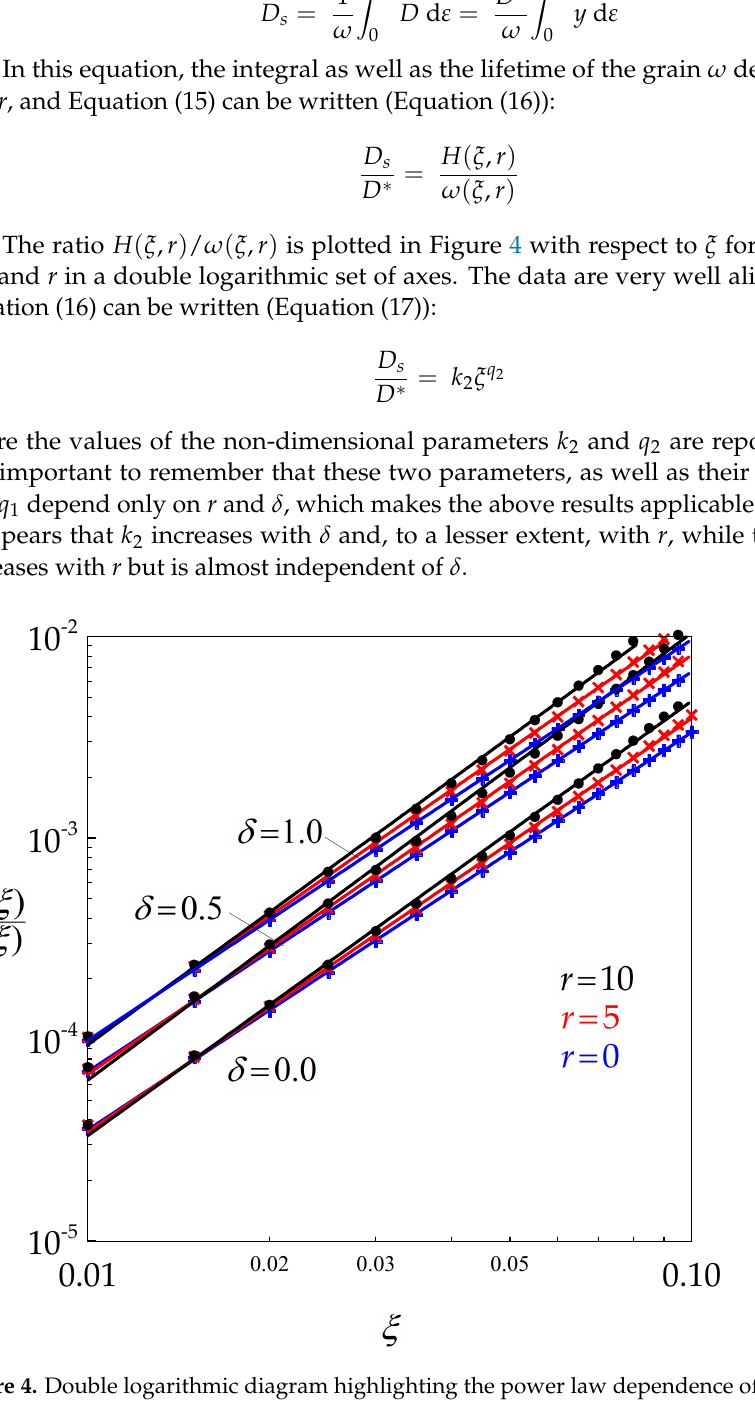
Figure 5. Diagram showing the dependence of the steady state grain size on the BMIS parameter for three values of the recovery coefficient r . Data points are connected by spline curves. Table 2. Numerical values of parameters